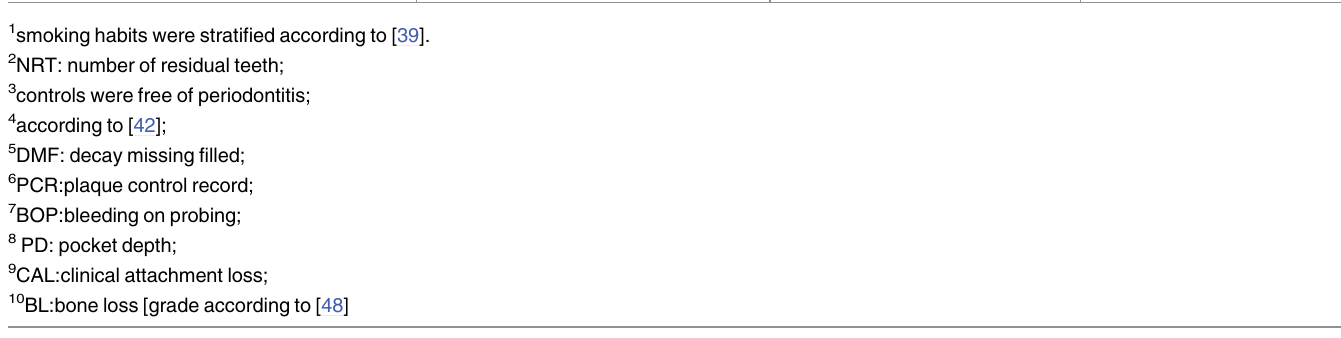
PCA was performed on periodontal variables from the 26 patients. The score plot is shown in Fig 1. No outlier was detected in the plan defined by the first and second principal components, PC1 and PC2, which correspond to 63% of the variability in the clinical data. Considering the positions of variables on the loadings plot, the loss of periodontal tissues (including CAL- MEAN, percentage of sites with severe or moderate CAL, BL), the criteria of active disease (MPD), and the percentage of bleeding sites (BOP) were strongly correlated and contribute strongly to PC1 variability.